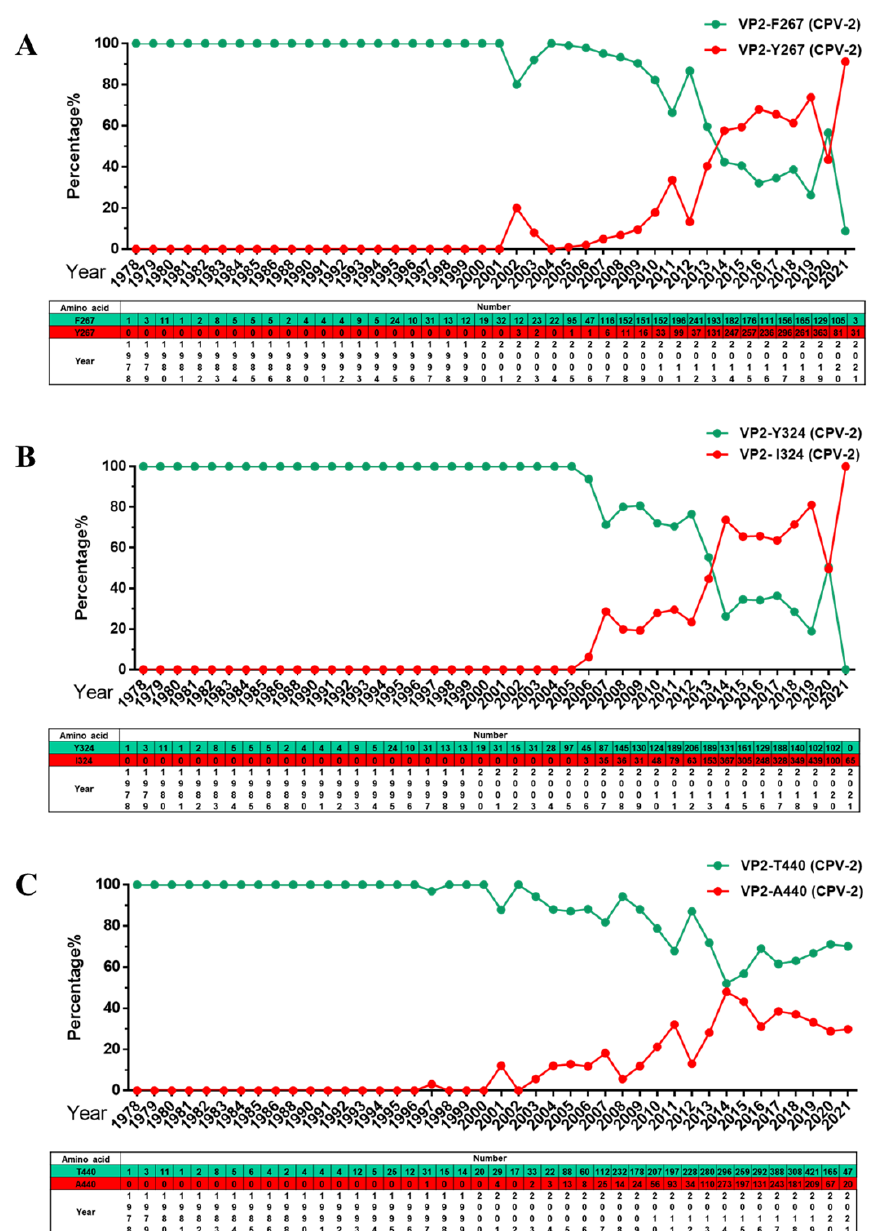
Figure 5. Analysis of global amino acid mutations at specific sites in the CPV-2 VP2 gene. ( A ) Per- centage and number of amino acids at site 267 of VP2. ( B ) Percentage and number of amino acids at site 324 of VP2. ( C ) Percentage and number of amino acids at site 440 of VP2.